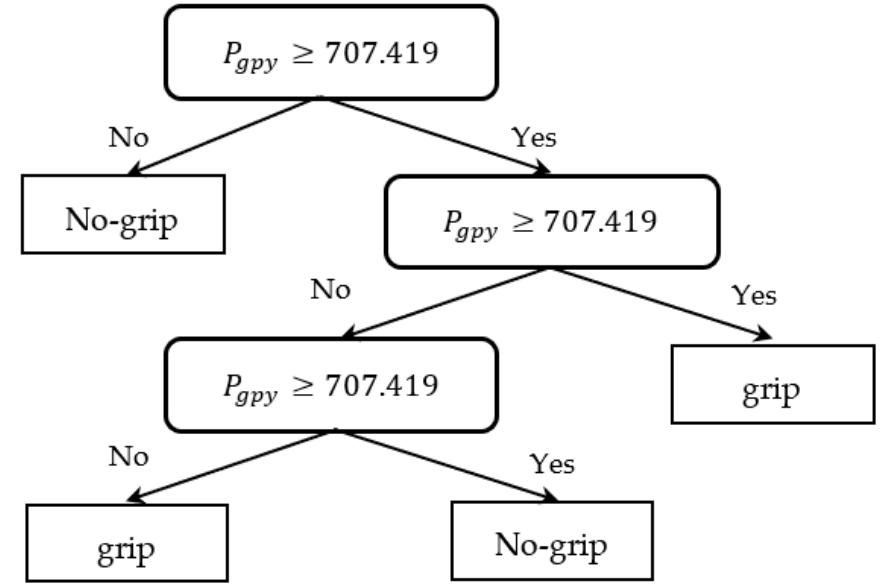
Figure 5. Grasping classification decision tree model in Environment 2.